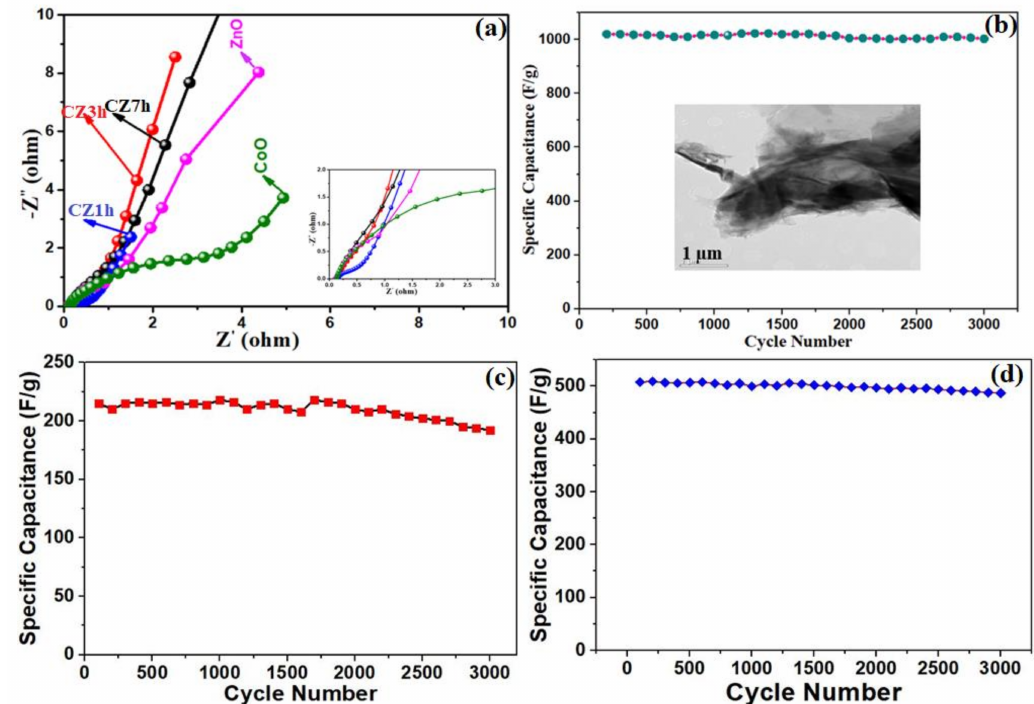
Figure 8. ( a ) Electrochemical impedance spectra (EIS) plots of the CoO, ZnO, CZ1h, CZ3h and CZ7h electrodes and ( b – d ) cycling stability performance of the CZ3h, CZ1h and CZ7h electrodes at 4 A/g for 3000